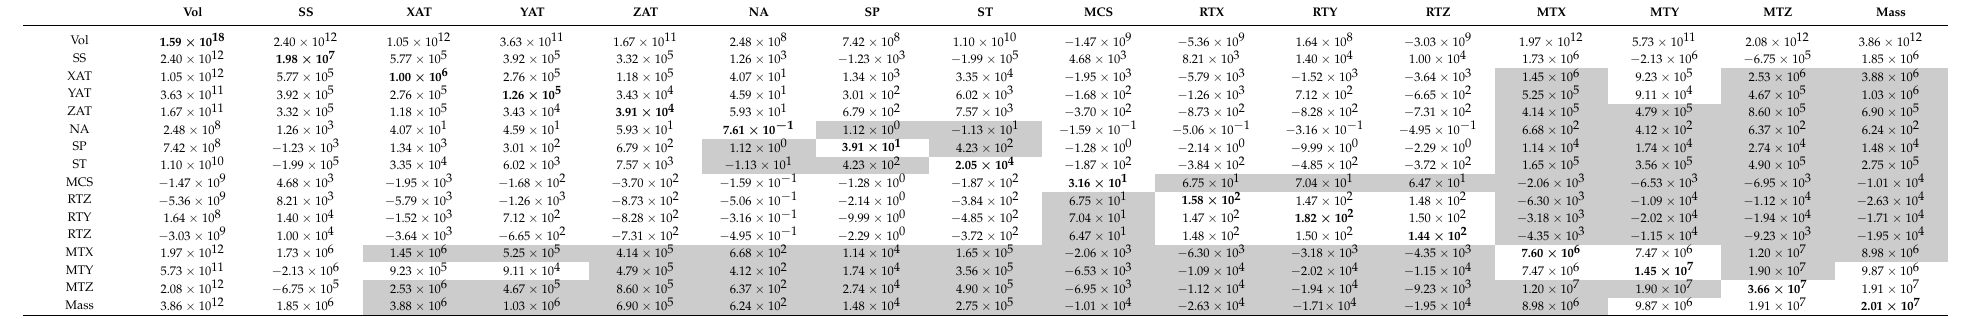
Table 3. Variance–covariance matrix for the Haas data with the variances (across the diagonal) in bold and the significant covariances shaded (see Table 2 for nomenclature).